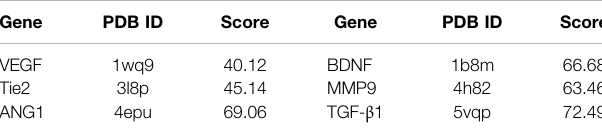
TABLE 6 | The scores of the small molecule and the target protein.